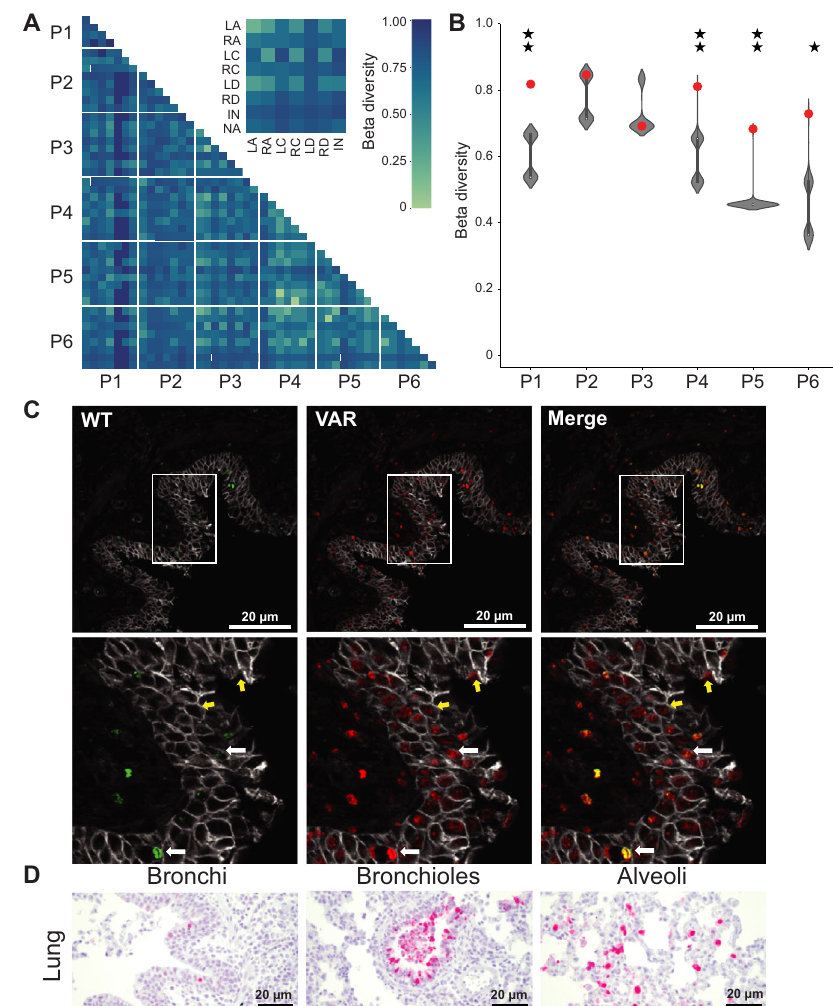
Fig. 5 | Reassortant viral populations show extensive compartmentalization within the swine respiratory tract. Heat map showing normalized beta diversity of viral populations in swine lung and nasal tract ( A ). The inset shows a repre- sentativecomparisonbetweenthetissuesofpigsP3andP6,toindicatetheposition of each tissue within the matrix. The tissue sites are abbreviated as NA-Nasal; LA- Left Apical; RA- Right Apical; LC-Left Cardiac; RC-Right Cardiac; LD-Left Dia- phragmatic; RD-Right Diaphragmatic; IN-Intermediate (accessory). Normalized beta diversity between the left apical and left cardiac lobes is plotted ( B ) with observed results (colored points) overlaid on the distribution of simulated data (gray violins) ( n =1000 simulations per pig). Data are presented as violin plots featuring a box plot. Data are presented as violin plots featuring a box plot. The boundsoftheboxshowtheinterquartilerangeandthecenteroftheboxshowsthe 50th percentile. Whiskers indicate 1.5 times the interquartile range and contain ∼ 99% ofthedataforanormaldistribution.Theboundsoftheviolinplotsindicate